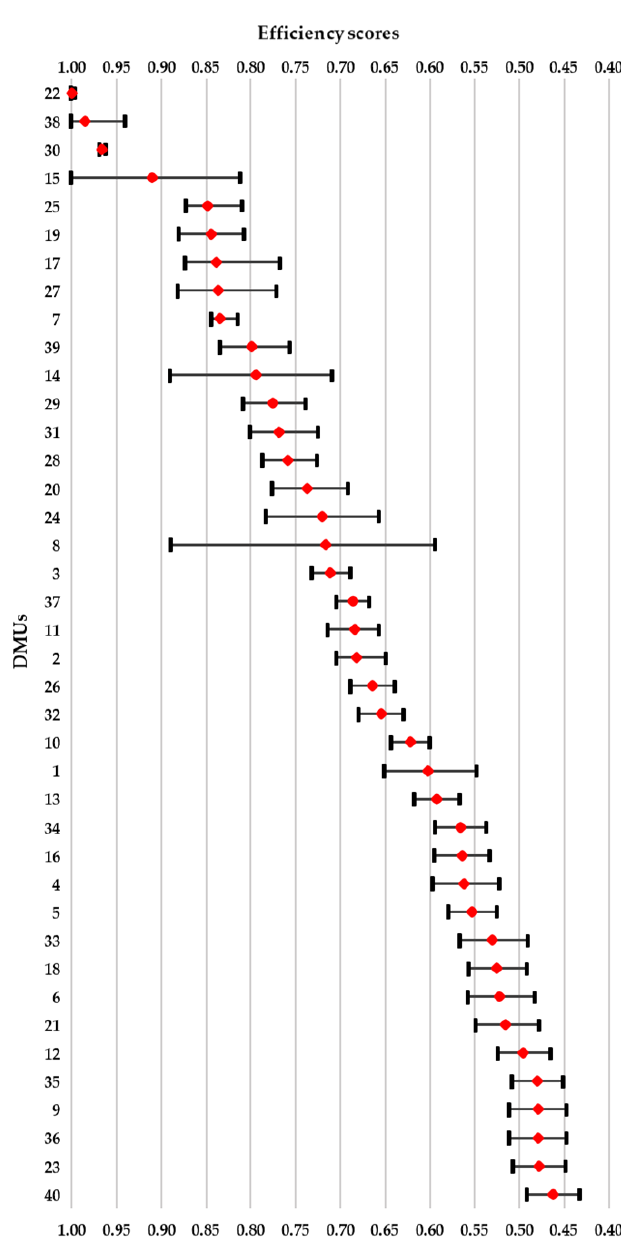
Figure 1. Results of FRM1 for dataset 2. DMUs vs. efficiency scores.